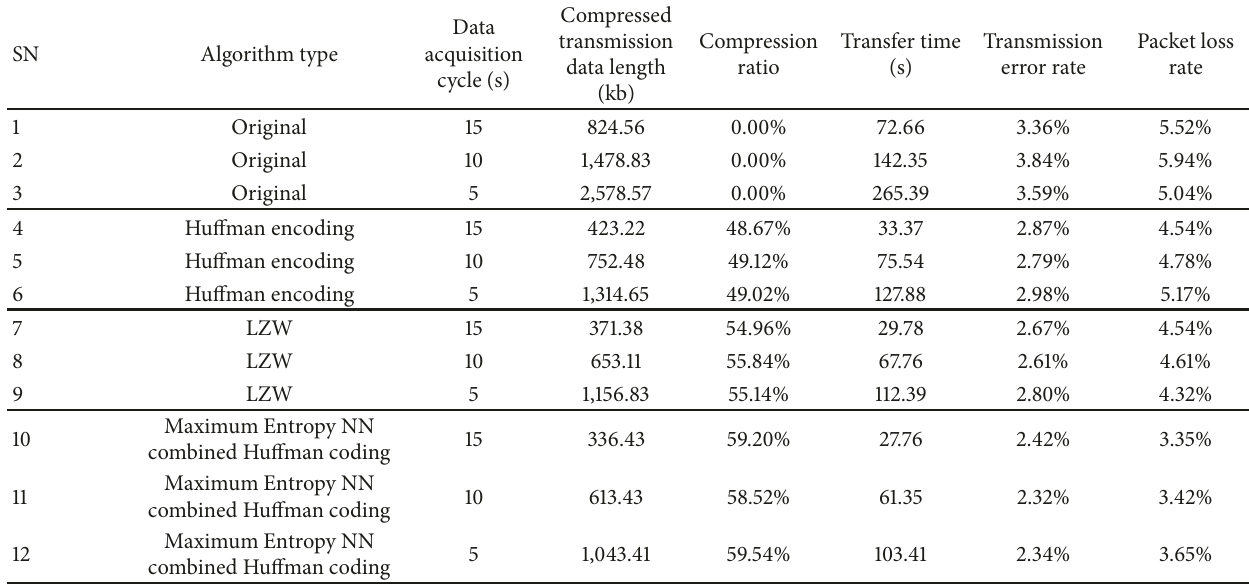
Table 2: Data compression test results.